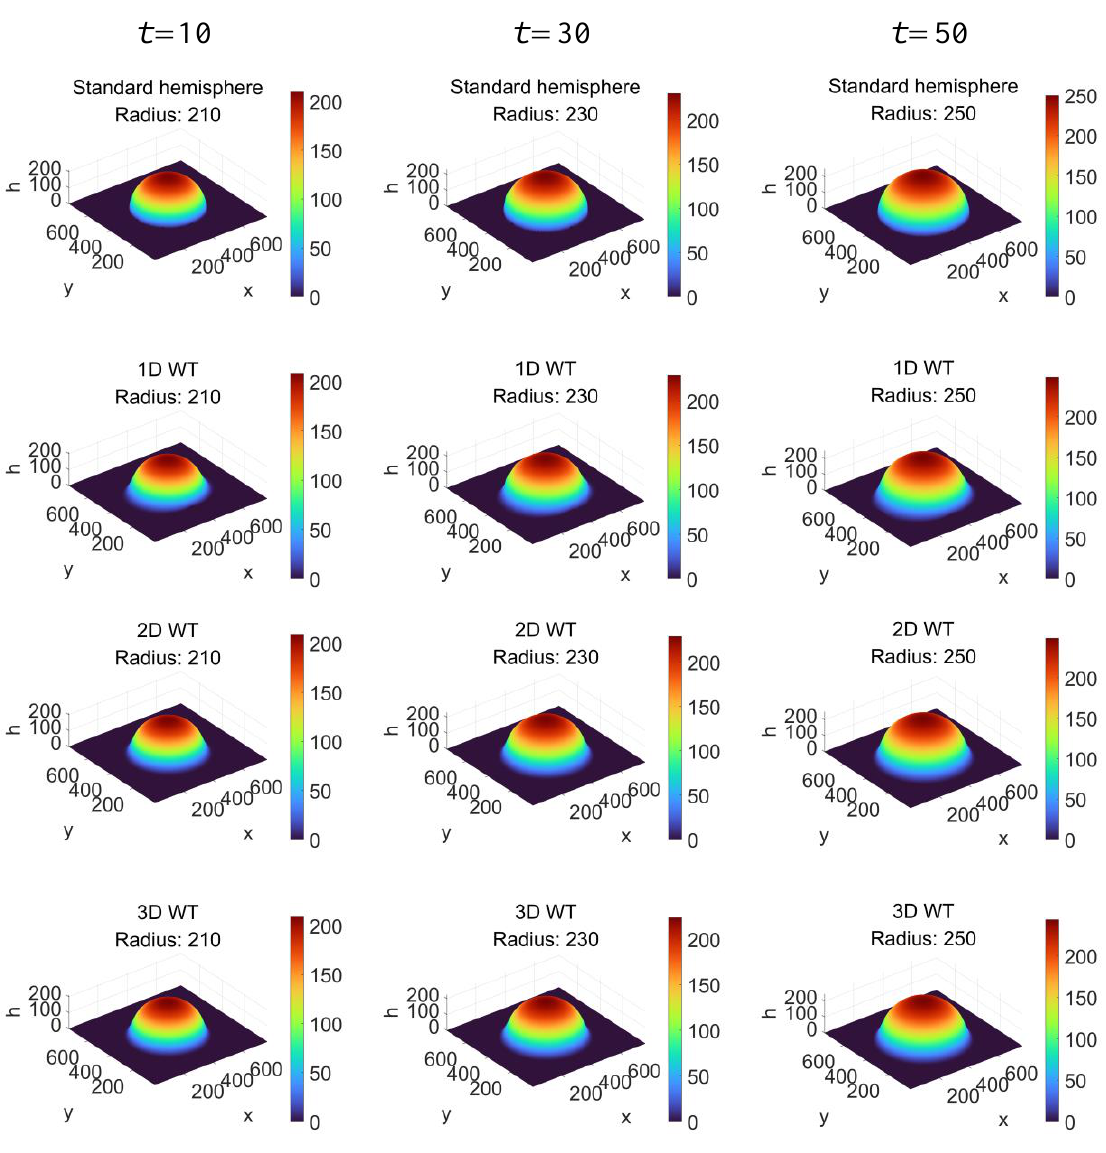
Figure 3. Standard hemisphere surface and hemisphere 3D reconstruction result with different methods.